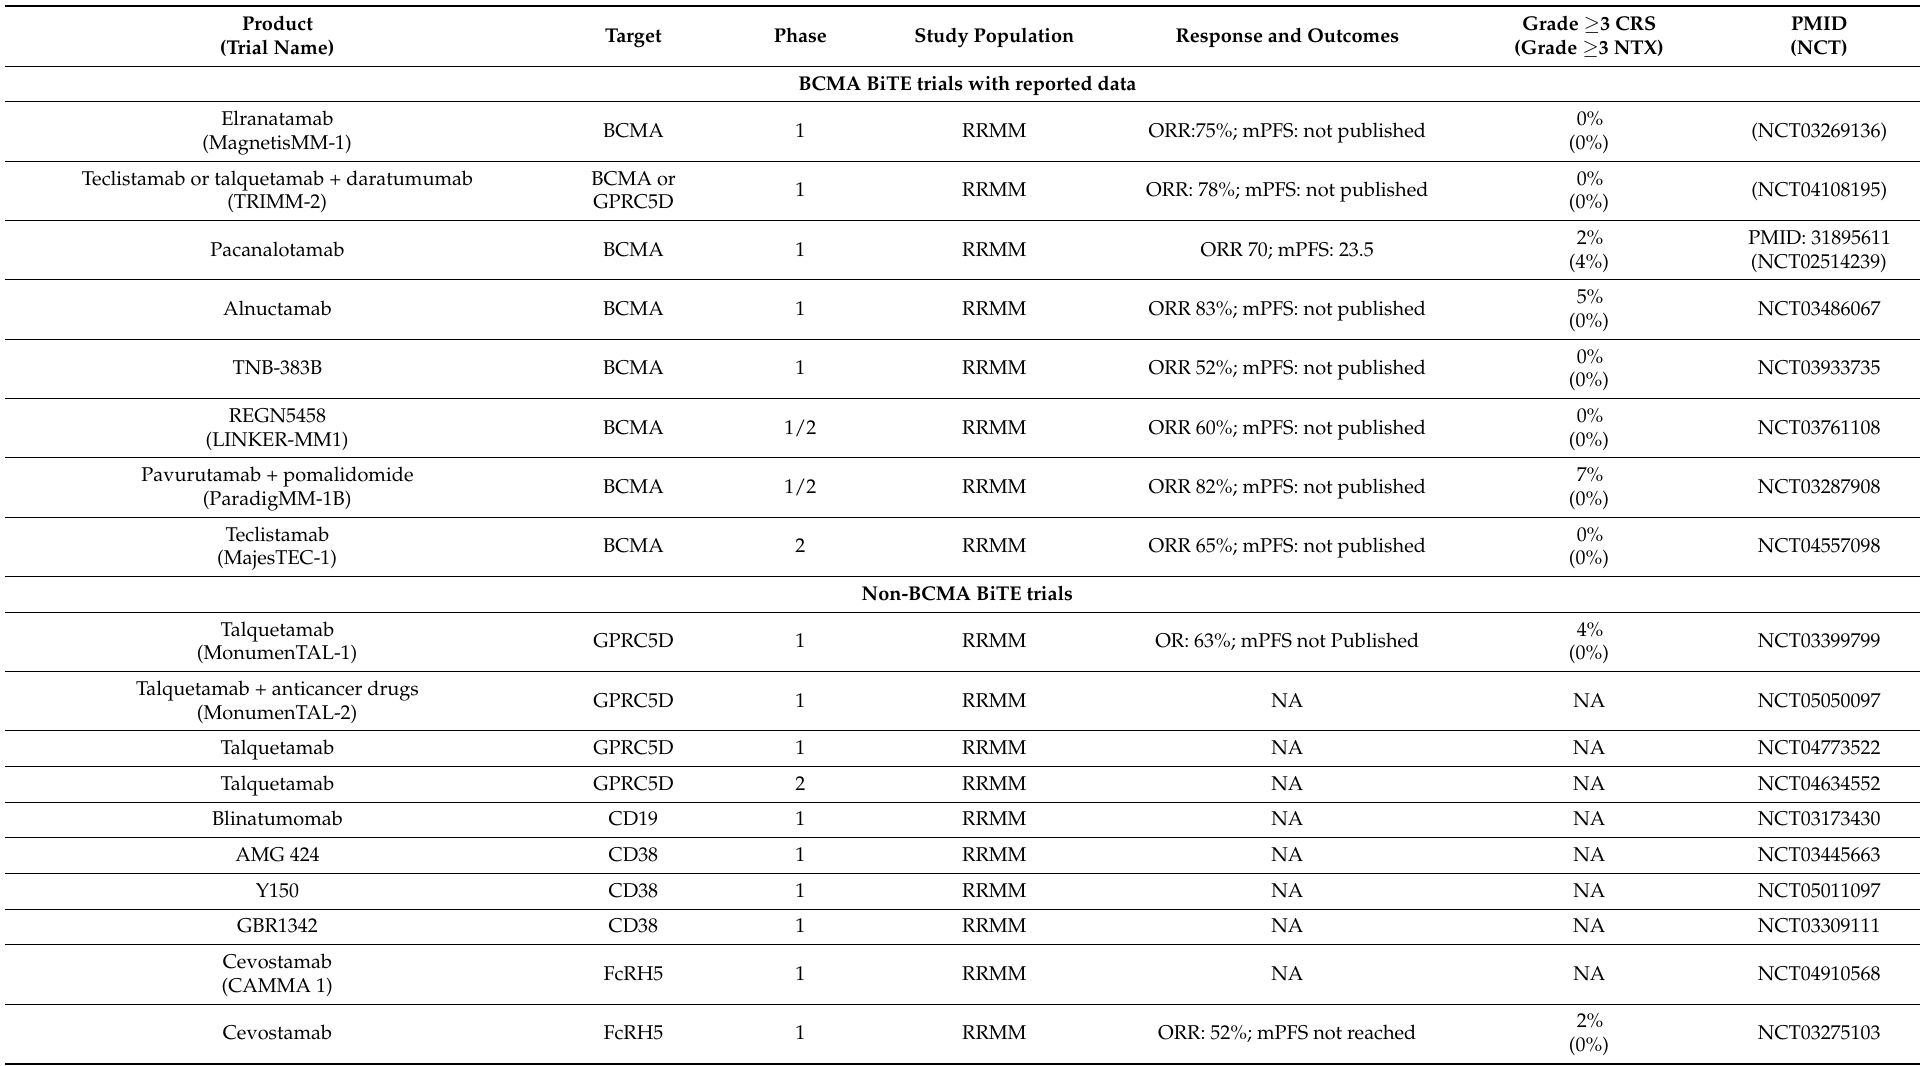
Table 2. Summary of BiTE Clinical Trials in